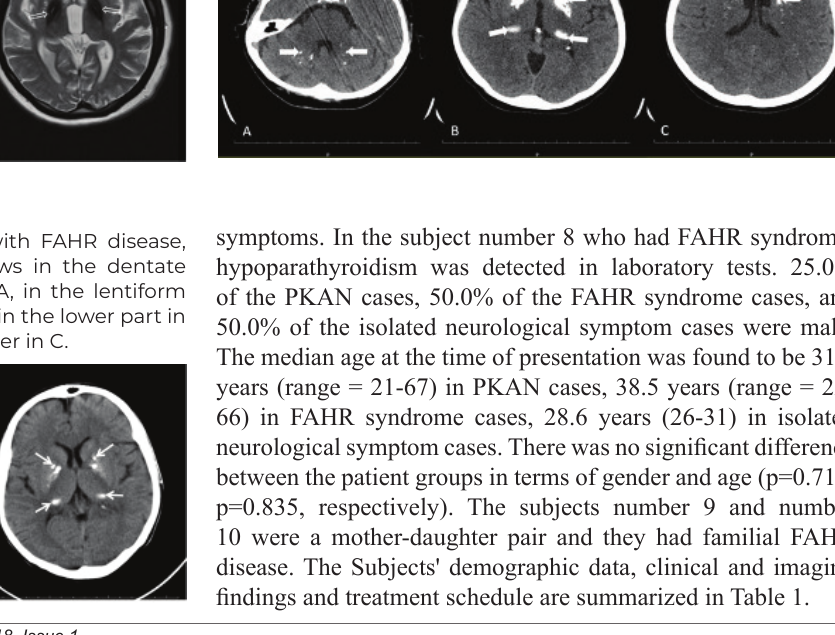
Figure 3 - Case 12: A 26-year-old patient diagnosed with Wilson disease, hyperintense signal changes secondary to the accumulation of substance in the right cerebellar hemisphere (A), brain stem (B), in both thalamus and basal ganglia (D) in axial T2 sections shown with white arrows. In C, face of the giant panda sign is being observed in the